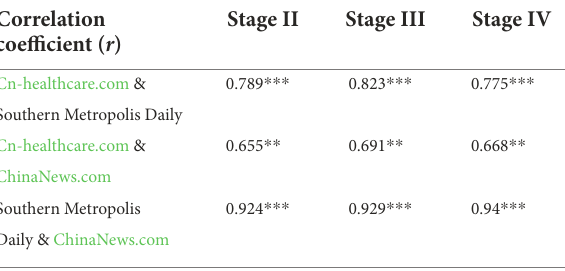
TABLE 2 Effectiveness of agenda setting different media.